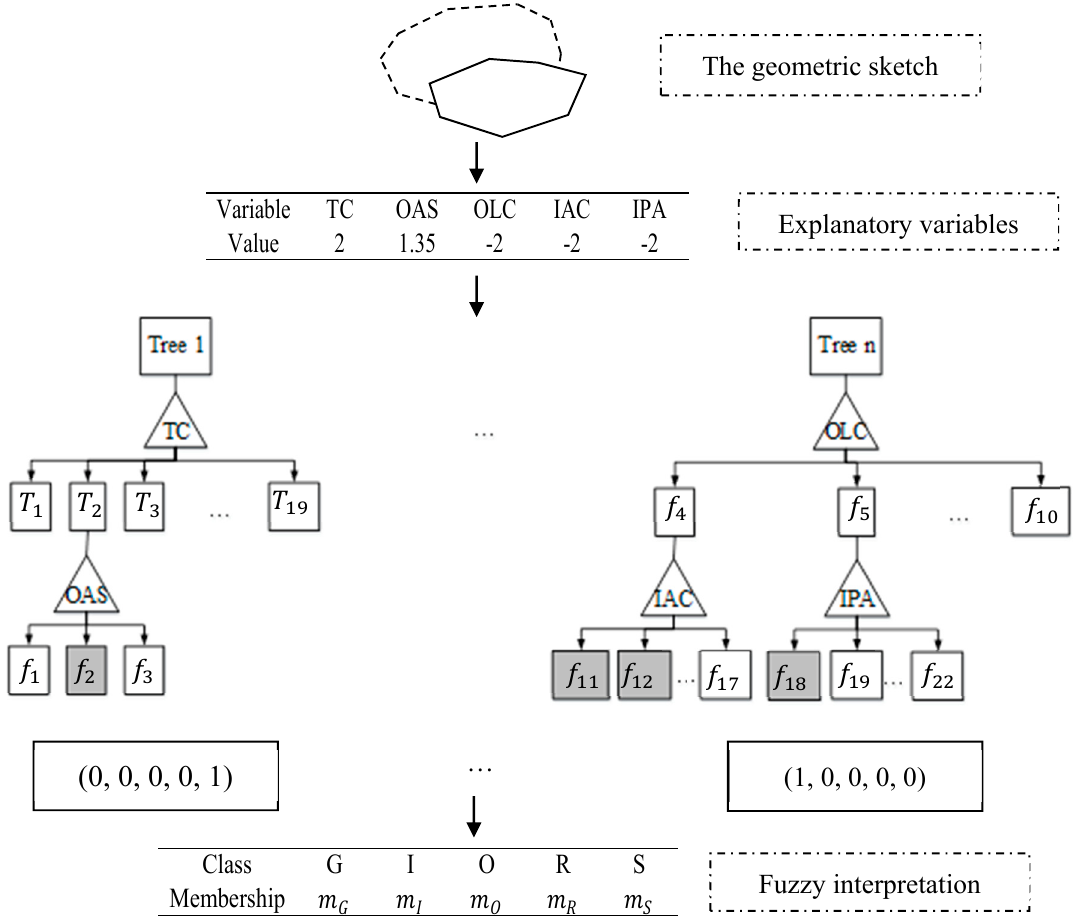
Figure 4. Fuzzy classification of FRF. Table 5. Different types of fuzzified samples.